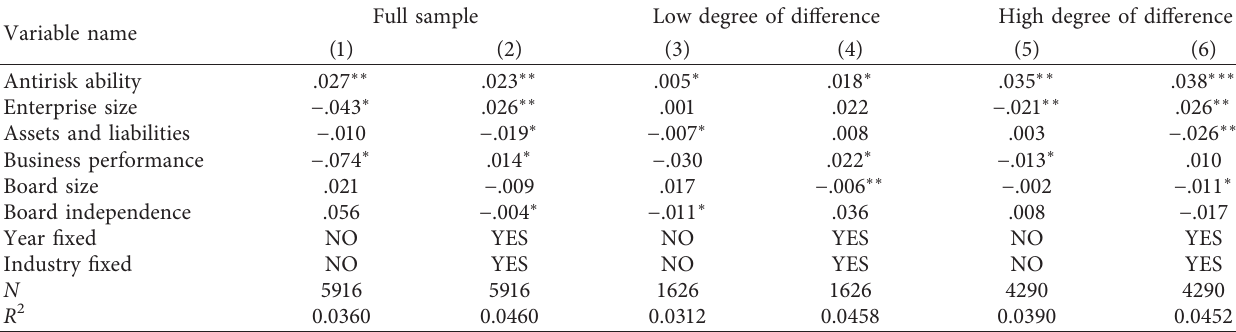
Table 4: Regression analysis results of antirisk ability and innovation performance.